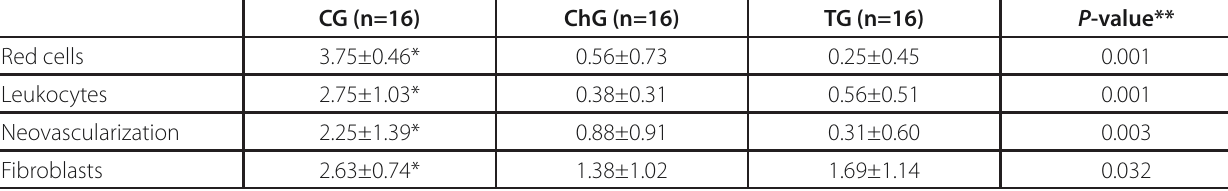
Table 4. Microscopic analysis according to the modified Ehrlich-Hunt classification [5]